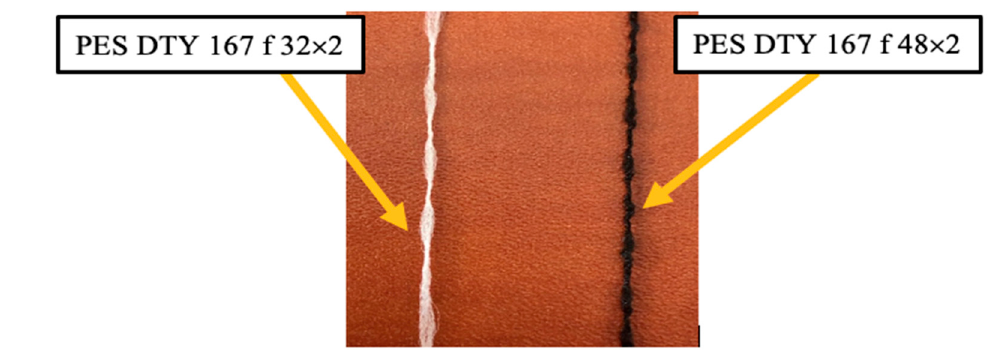
Figure 1. Selected fabric structure interlacement.